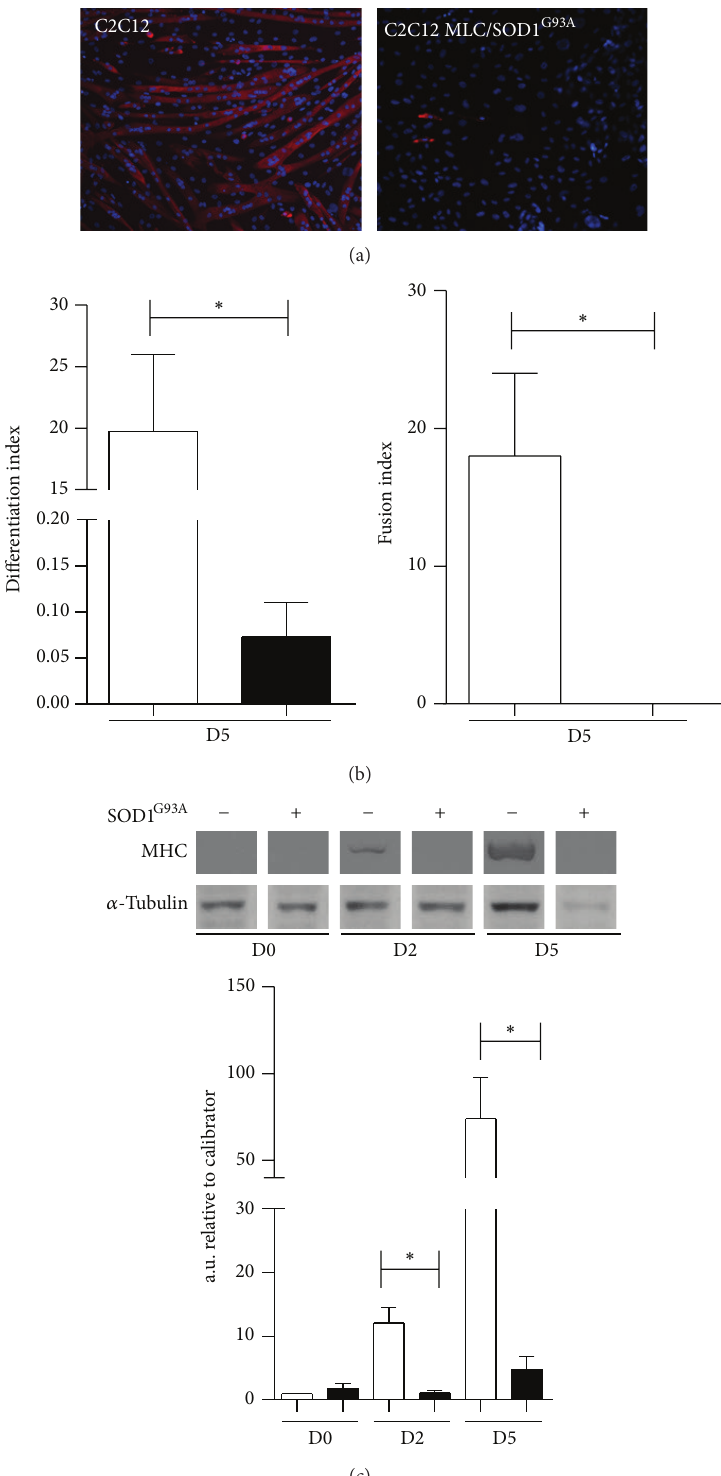
Figure 2: Postmitotic expression of mutant SOD1 gene inhibits C2C12 cells differentiation. (a) Representative immunofluorescence images of C2C12 and C2C12 MLC/SOD 1 G 93 A cells stained with anti-myosin heavy chain (MHC)antibody after 5 days in differentiation medium. (b) The histograms represent the differentiation index (left panel) and fusion index (right panel) in control (white bars) and transfected cells (black bars). (c) Upper panel shows representative western blot analysis of MHC expression in C2C12 and C2C12 MLC/SOD 1 G 93 A cells. Lower panel shows densitometric analysis for MHC expression in C2C12 (white bars) and C2C12 MLC/SOD 1 G 93 A (black bars). D0, D2, and D5 referred to days of culture in differentiation condition. Data are represented as mean ± SEM ( ∗ 𝑃 < 0.05